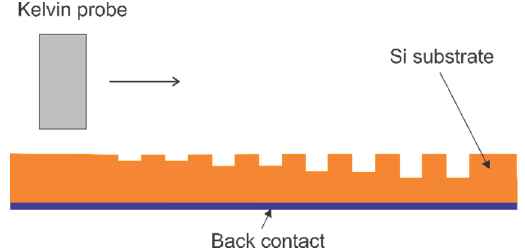
Figure 4. Work function measurement setup .